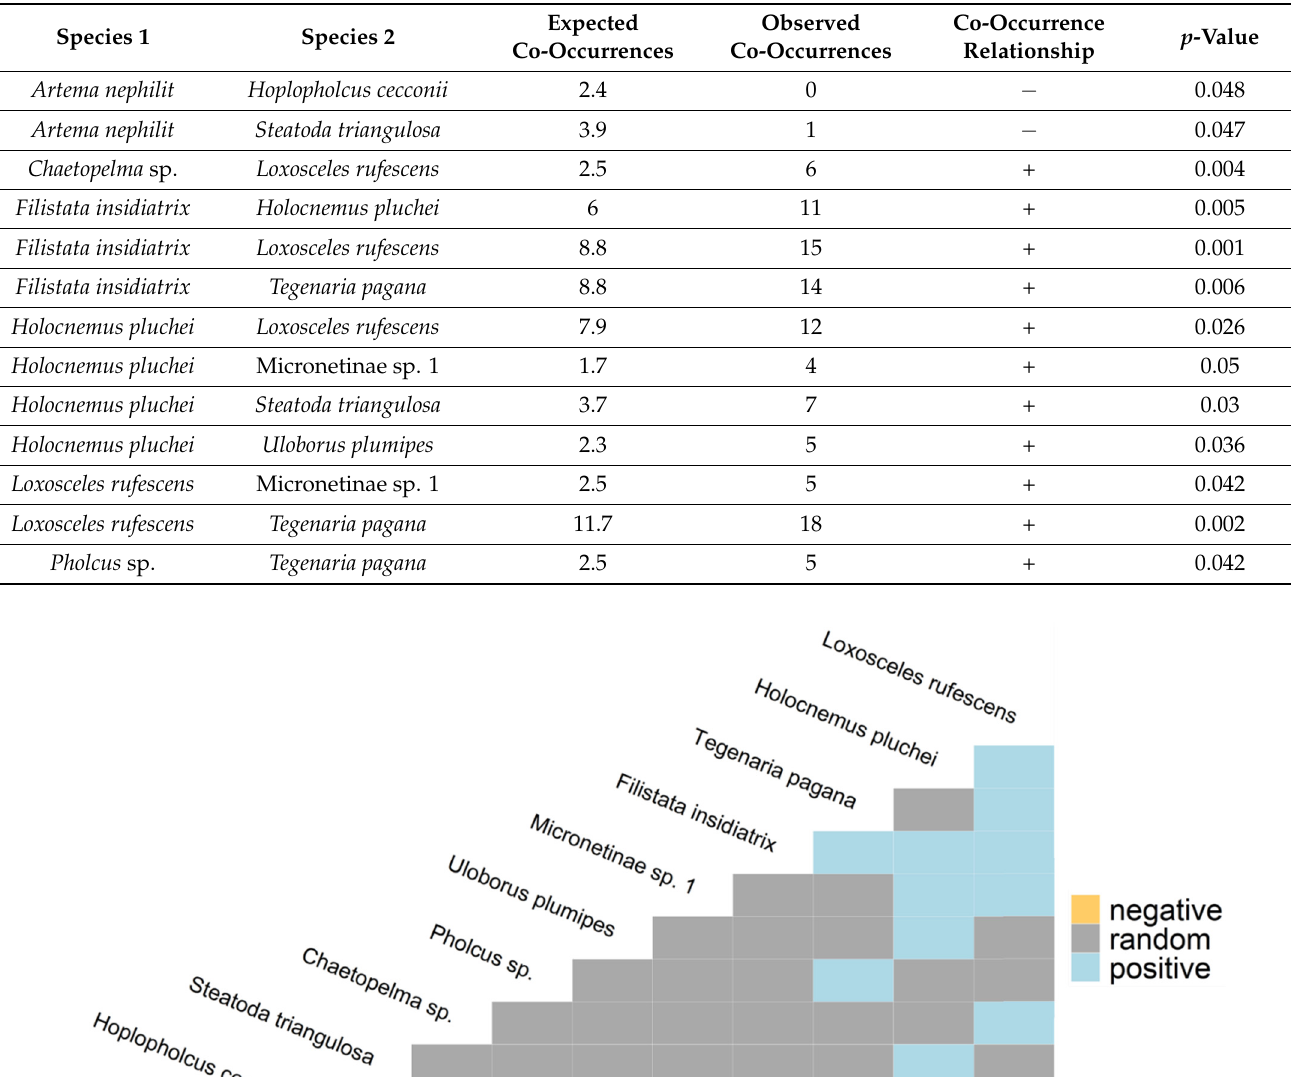
Table 2. Species co-occurrence across cave zones. The probability corresponds to the probability that the respective species co-occur more, or less, than expected (listed as “relationship”, with “+” and “ − ” denoting positive and negative co-occurrences, respectively). Negatively co-occurring species are in bold.